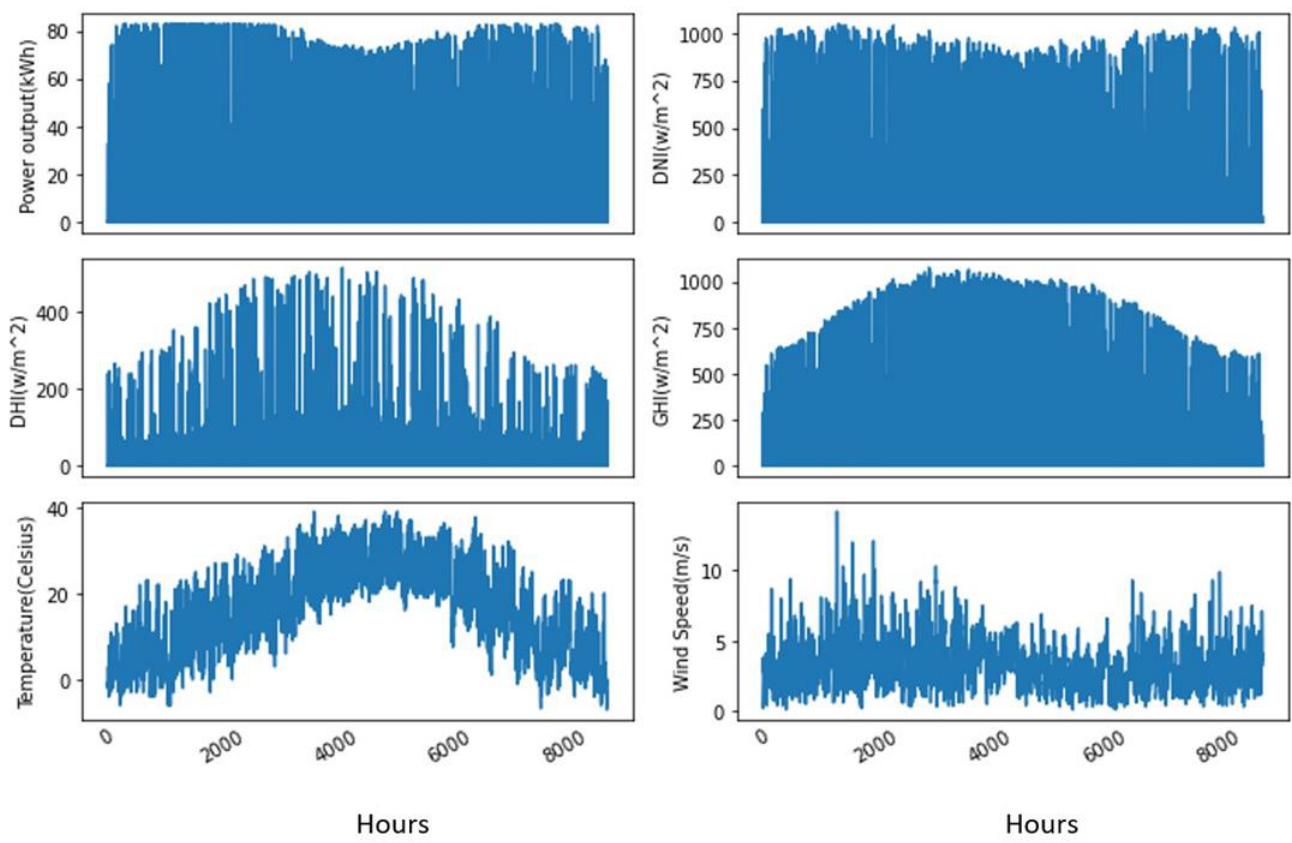
Figure 3. Graphical representation of data utilized in the